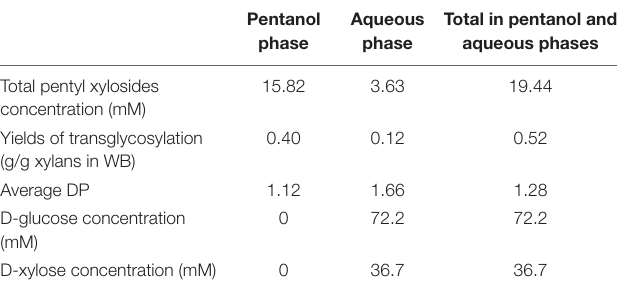
TABLE 1 | Quantification of total β -D-pentyl xylosides (DP1–DP3) and monosaccharides present in the pentanol and aqueous phases after 48 h of transglycosylation reaction catalyzed by Cellic Ctec2 in the presence of WB and pentanol 50% in water.